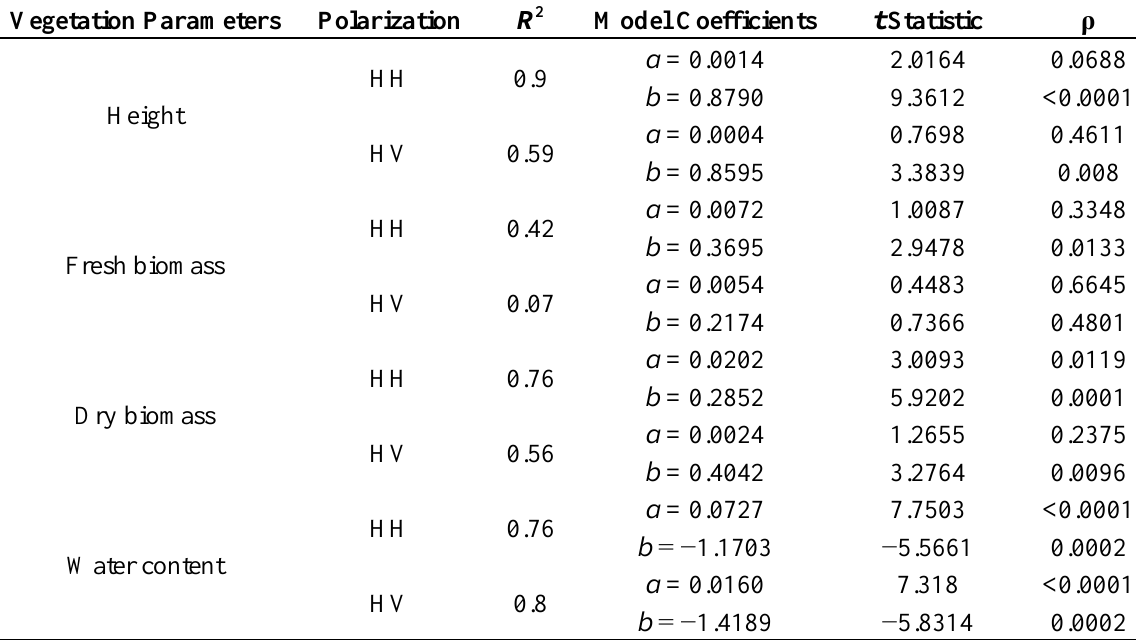
Table 3. Model parameters used to quantify the relationships of ASAR backscattering coefficients with vegetation parameters of Phragmites